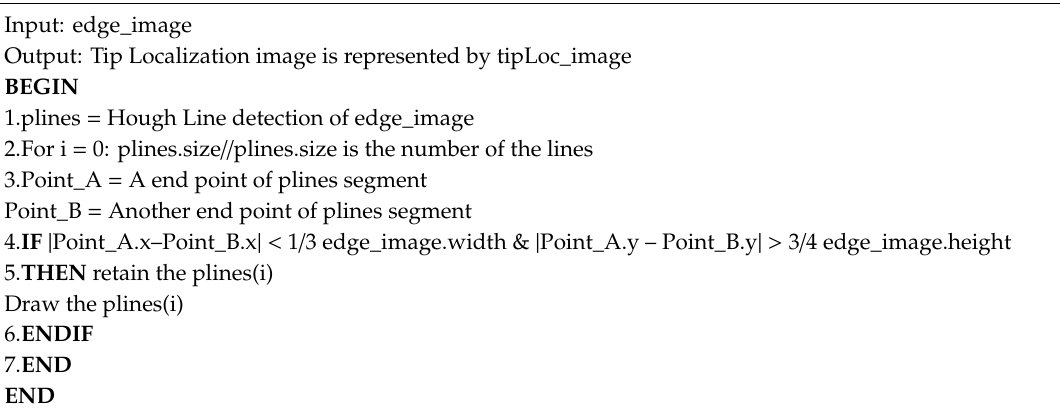
Algorithm 2: Boundary Detection of